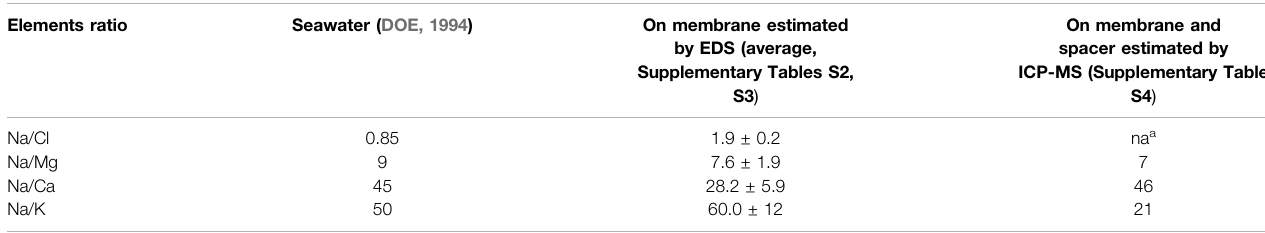
TABLE 2 | Ratio of sodium with respect to other main elements found on the